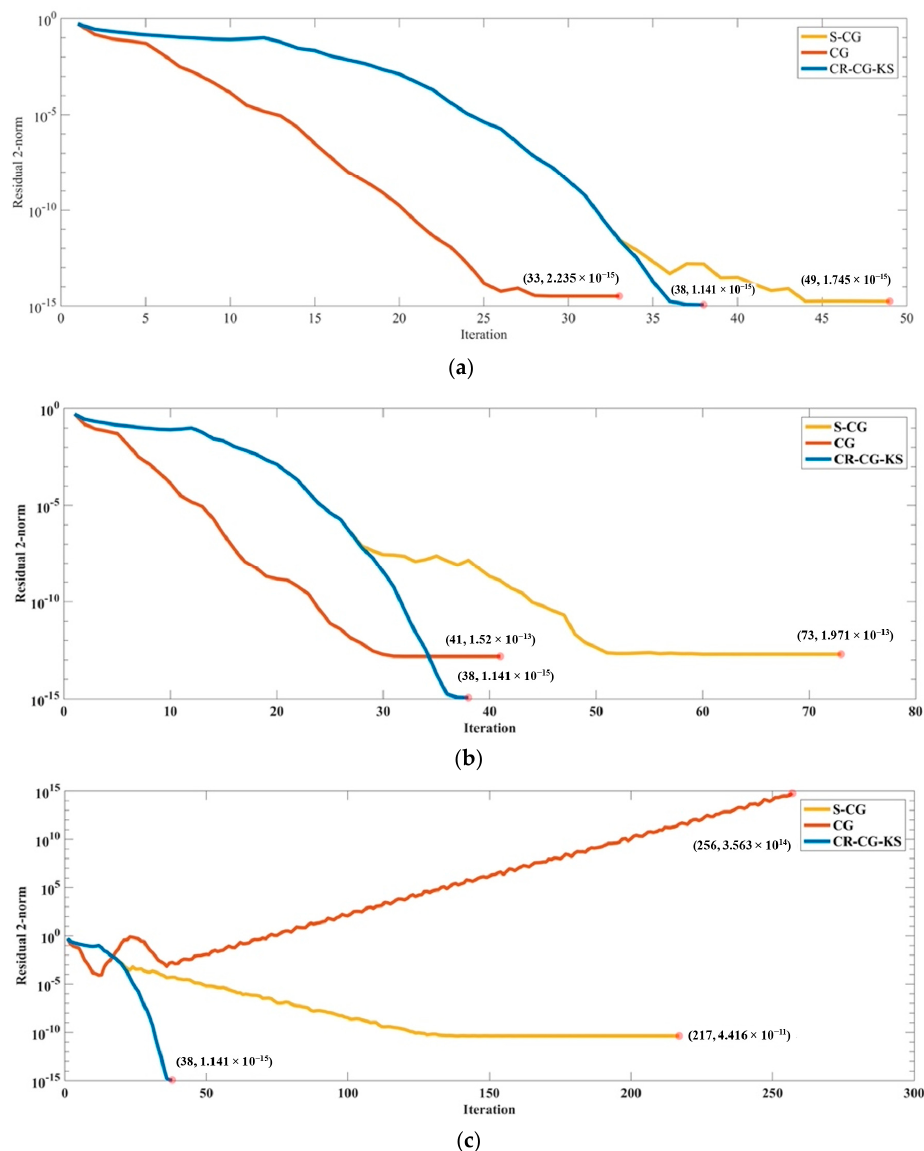
Figure 1. Sparse matrix algorithm comparison: ( a ) S = 4; ( b ) S = 8; ( c ) S = 12. From Figure 1, CG reaches convergence at the 33rd time when S = 4, and the conver ‐ gence speed is the fastest, but the residual values are larger than the other two methods, and the calculation accuracy is not high. When S = 8, the number of iterations is 41, and the residual value is also more than 100 times different from those when S = 4. When S = 12, the number of iterations is 217. Although the residual meets the convergence require ‐ ments, the calculation time is long, and the calculation memory is too much. It can be seen that the number of inner loops has a great influence on the calculation results obtained by CG. In contrast, S ‐ CG sequentially selects the orthogonal S ‐ direction vectors of A to form an orthogonal orientation matrix, while minimizing the residual vectors in these S ‐ direc ‐ tions) [28]. When S = 4 and S = 8, the variation of iteration number and residual distance is similar to those of CG. The residual value reaches the optimal value when S = 8, but the convergence requirement cannot be satisfied when S = 12. CR ‐ CG ‐ KS proposed in this paper has the same iteration number and residual values when S = 4, 8 and 12. The residual values are the minimum values among those of these three algorithms. It can be seen that CR ‐ CG ‐ KS has better stability and accuracy. 4.3. Reconfiguration Analysis of Global Container Shipping Network 4.3.1. The Major Container Shipping Network According to the data collection of the global container shipping network with 237 major ports and considering the practical application, the data are discrete and analyzed to obtain the optimal solution and scheme. Figure 2a–c show the result comparisons among the three methods.